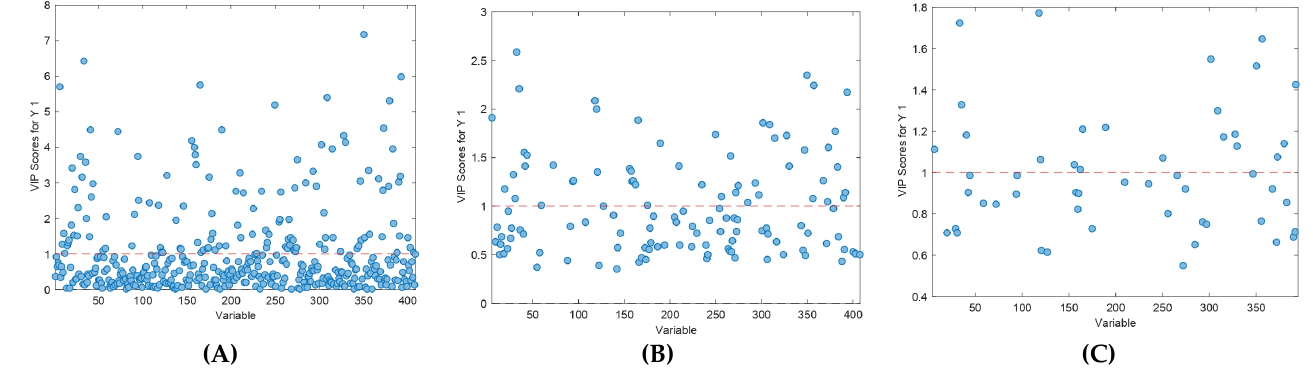
Figure 3. Consecutive VIP score evaluation performed for feature reduction in Model 2 (targeted approach), repeated three times ( A – C ) and eliminating features with a VIP value < 1.